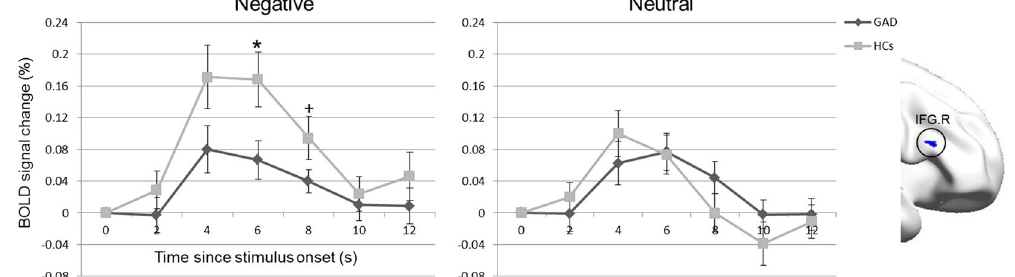
Figure 4. Dynamic neural response in the right IFG during negative and neutral stimuli evaluation. IFG = inferior frontal gyrus, GAD = generalized anxiety disorder, HCs = healthy controls, and R = right. Error bar denotes the SEM. * p < 0.05, + p =